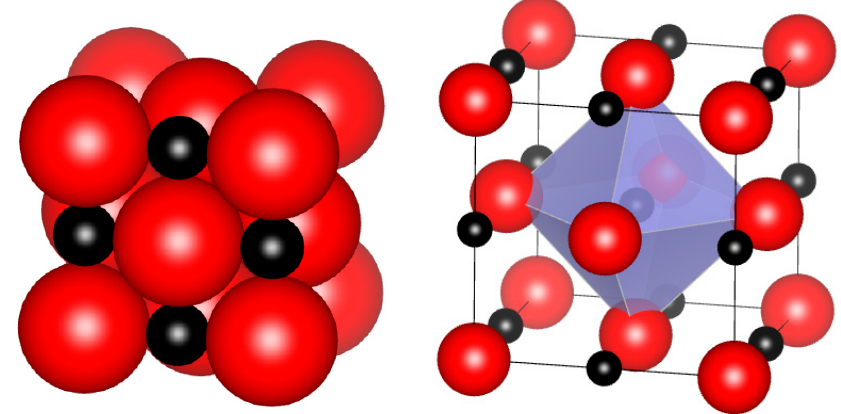
Figure 3. Rocksalt structure in space-filling and polyhedral representations, showing the location of nonmetal atoms in octahedral voids of a face-centered cubic metal sublattice. Red spheres indicate metal atoms.